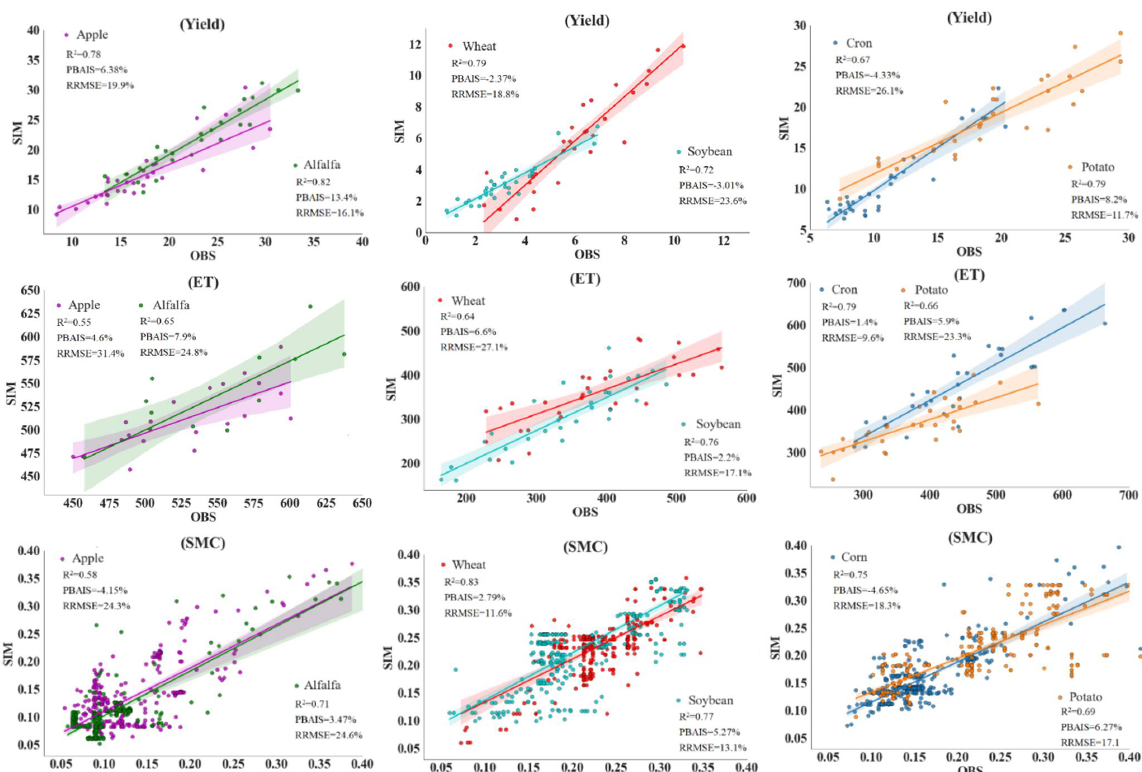
Figure 4. Observed (OBS) yield (t ha − 1 ), evapotranspiration (ET, mm), and soil moisture content (SMC, cm 3 cm − 3 ) vs. simulated (SIM).